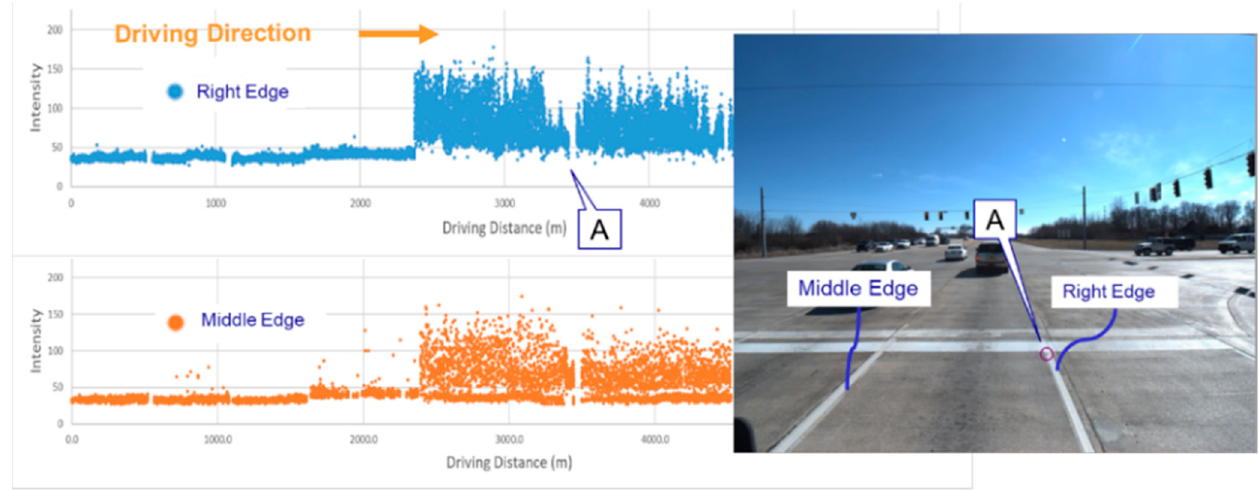
Figure 18. Intensity profiles and corresponding RGB imagery for location A.